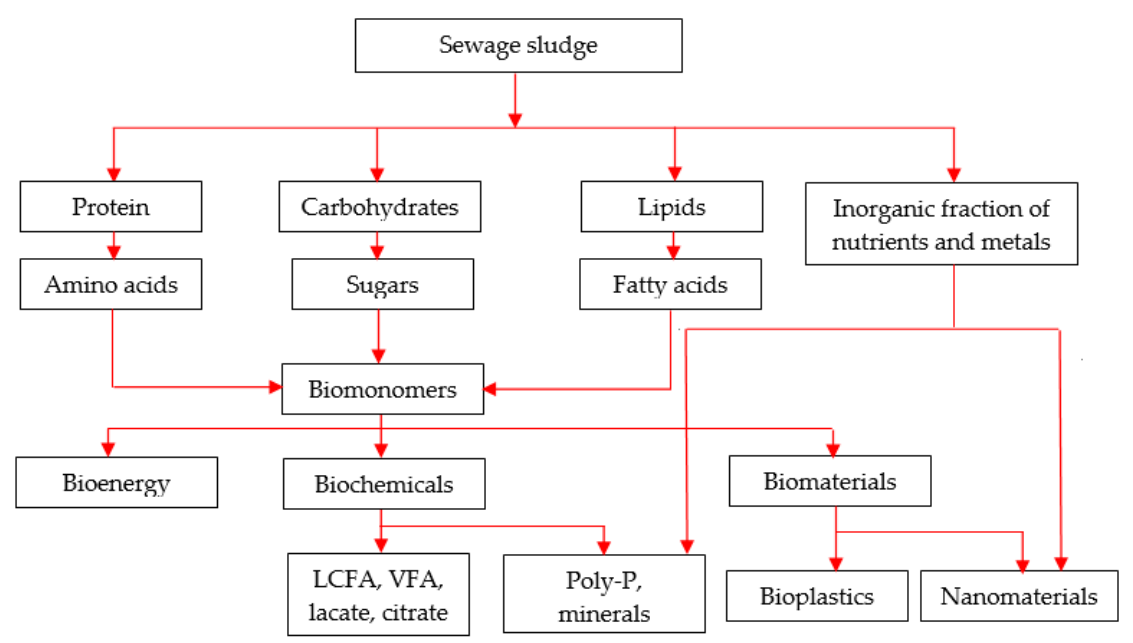
Figure 1. Energy carriers and added-value products recoverable under the ‘WWTP as an integrated biorefinery’ approach (inspired by [1,3,4]).